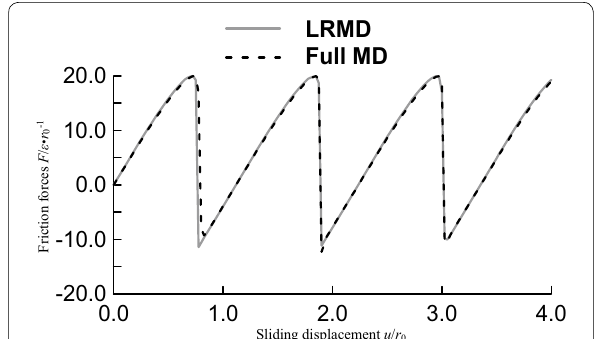
Figure 4 Friction forces comparison between LRMD simulation and full MD simulation (113 81) ×